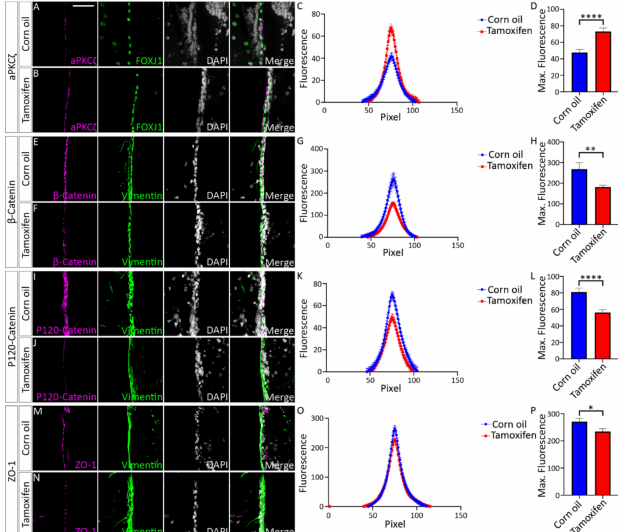
Figure 9. Tamoxifen treated Nfix iFOXJ1 − GFP ependymal cells demonstrate reduced expression of adhesion proteins. ( A , B ) Lateral ventricle sections from Nfix iFOXJ1 − GFP mice treated with corn oil ( A ) and tamoxifen ( B ) at 7 dpi labelled with aPKC ζ (purple), ependymal cell marker FOXJ1 (green) and nuclear marker DAPI (grey), displayed separately and merged. ( C ) Average aPKC ζ fluorescent intensity across the cell junction is displayed for tamoxifen treated Nfix iFOXJ1 − GFP ependymal cells and controls. Average aPKC ζ fluorescent intensity across the cell junction was increased at the peak in tamoxifen treated Nfix iFOXJ1 − GFP ependymal cells compared to controls. ( D ) Maximum aPKC ζ fluorescent intensity is displayed for tamoxifen treated Nfix iFOXJ1 − GFP ependymal cells and controls. Maximum aPKC ζ fluorescent intensity is significantly increased in tamoxifen treated Nfix iFOXJ1 − GFP ependymal cells compared to controls. ( E , F ) Lateral ventricle sections from Nfix iFOXJ1 − GFP mice treated with corn oil ( E ) and tamoxifen ( F ) at 7 dpi labelled with β -Catenin (purple), ependymal cell marker Vimentin (green) and nuclear marker DAPI (white), displayed separately and merged. ( G ) Average β -Catenin fluorescent intensity across the cell junction is displayed for tamoxifen treated Nfix iFOXJ1 − GFP ependymal cells and controls. Peak β -Catenin fluorescent intensity is reduced in tamoxifen treated Nfix iFOXJ1 − GFP mice compared to controls. ( H ) Maximum β -Catenin fluores- cent intensity across the junction measured from tamoxifen treated Nfix iFOXJ1 − GFP ependymal cells and controls. Maximum β -Catenin fluorescence was significantly reduced in tamoxifen treated Nfix iFOXJ1 − GFP treated mice compared to controls. ( I , J ) Lateral ventricle sections from Nfix iFOXJ1 − GFP mice treated with corn oil ( I ) and tamoxifen ( J ) at 7 dpi labelled with P120-Catenin (purple), ependy- mal cell marker Vimentin (green) and nuclear marker DAPI (white), displayed separately and merged. ( K ) Average P120-Catenin fluorescent intensity across the cell junction is displayed for tamoxifen treated Nfix iFOXJ1 − GFP ependymal cells and controls. Peak P120-Catenin fluorescent intensity is reduced in tamoxifen treated Nfix iFOXJ1 − GFP mice compared to controls. ( L ) Maximum P120-Catenin fluorescent intensity across the junction measured from tamoxifen treated Nfix iFOXJ1 − GFP ependymal cells and controls. Maximum P120-Catenin fluorescence was significantly reduced in tamoxifen treated Nfix iFOXJ1 − GFP treated mice compared to controls. ( M , N ) Lateral ventricle sections from Nfix iFOXJ1 − GFP mice treated with corn oil ( M ) and tamoxifen ( N ) at 7 dpi labelled with ZO-1 (purple), ependymal cell marker Vimentin (green) and nuclear marker DAPI (white), displayed separately and merged. ( O ) Average ZO-1 fluorescent intensity across the cell junction is displayed for tamoxifen treated Nfix iFOXJ1 − GFP ependymal cells and controls. Peak ZO-1 fluorescent intensity is reduced in tamoxifen treated Nfix iFOXJ1 − GFP mice compared to controls. ( P ) Maximum ZO-1 fluorescent intensity across the junction measured from tamoxifen treated Nfix iFOXJ1 − GFP ependymal cells and controls. Maximum ZO-1 fluorescence was significantly reduced in tamoxifen treated Nfix iFOXJ1 − GFP treated mice compared to controls. * p < 0.05, ** p < 0.01, **** p < 0.0001, two-tailed t -test. Graphs depict mean ± s.e.m. from three samples per genotype with an n of 150 junctions. Scale bar ( A ) represents 50 µ